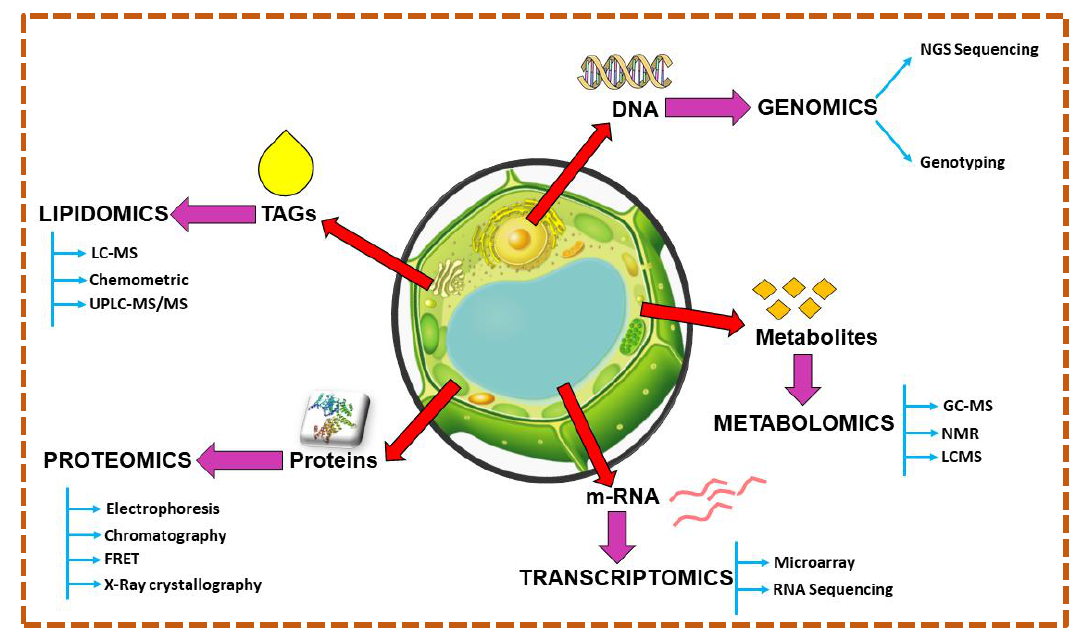
Figure 3. Overview of multi-omics approach in microalgae.